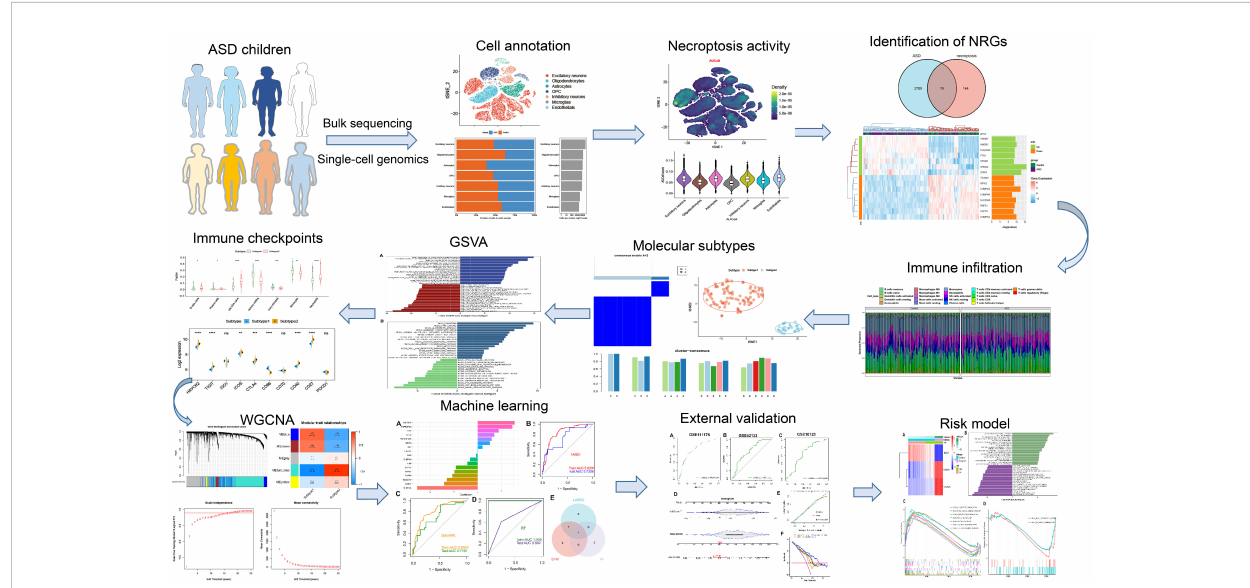
FIGURE 1 The fl ow chart of this study. *p < 0.05, **p < 0.01, ***p < 0.001, ****p < 0.0001, and ns no signi fi